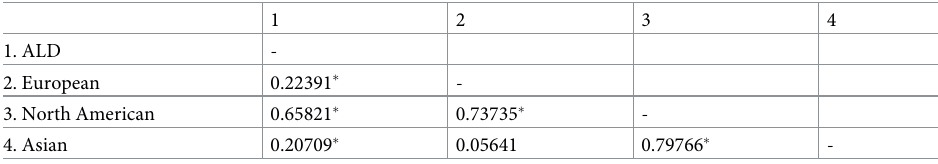
Table 3. Pairwise F st values of ALD and other major duck clades.